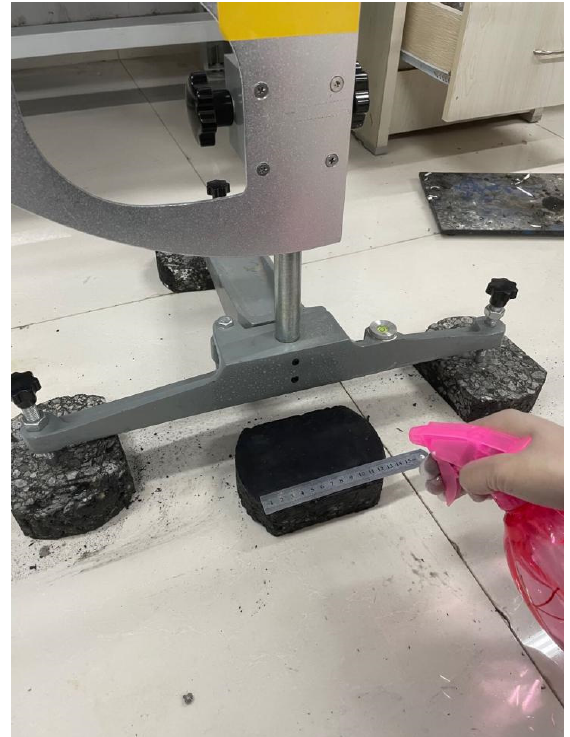
Figure 6. British pendulum tester.